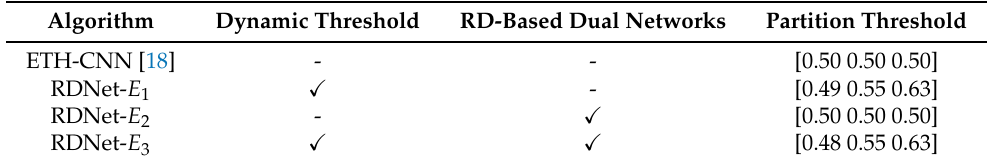
Table 2. The detail of the four groups ablation experiments.